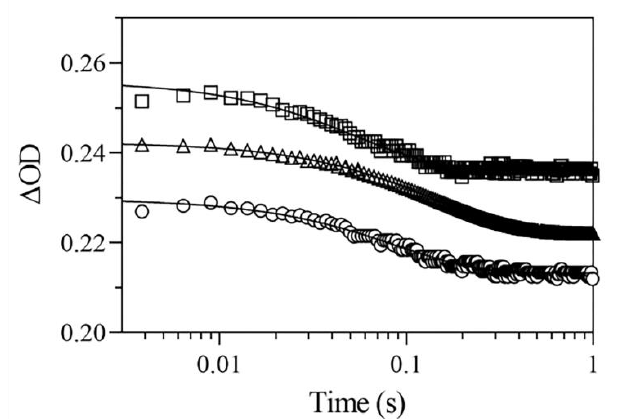
Figure 11. O 2 dissociation from Mt -Nb(II)-O 2 (circles), At -Nb(II)-O 2 (triangles), and Hs -Nb(II)-O 2 (squares) by oxygen pulse experiments, at λ = 414 nm, pH 7.0 and 25.0 ◦ C. The continuous lines were (squares) by oxygen pulse experiments, at λ = 414 nm, pH 7.0 and 25.0 °C. The continuous lines obtained according to Equation (1) with the following values of k off(O2) : (1.1 ± 0.1) × 10 1 s − 1 were obtained according to Eqn. 1 with the following values of k off(O2) : (1.1 ± 0.1) × 10 1 s −1 (circles),